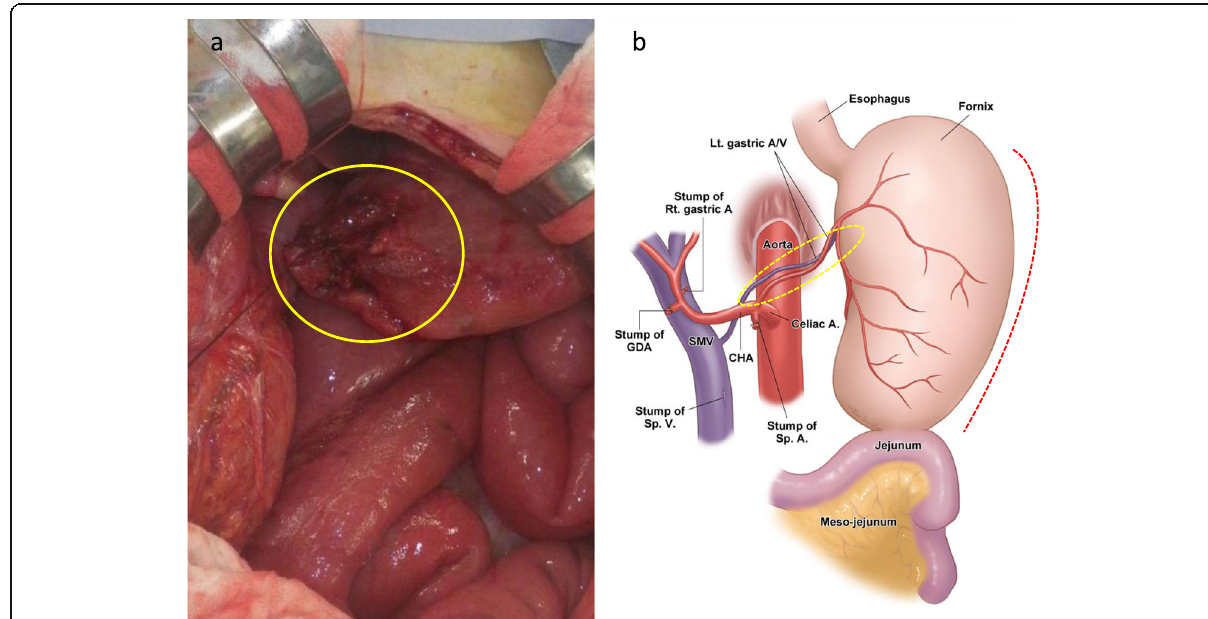
Fig. 3 Intraoperative findings and schema following gastric volvulus release. a The yellow circle indicates the fornix of the stomach and perforated lesion. b The remnant stomach after total pancreatectomy with splenectomy is fixed only by the pedicle of the left gastric artery and vein (dotted circle). The greater curvature (dotted line) was fixed to the left abdominal wall. Celiac A., celiac artery; Lt. gastric A/V, left gastric artery and